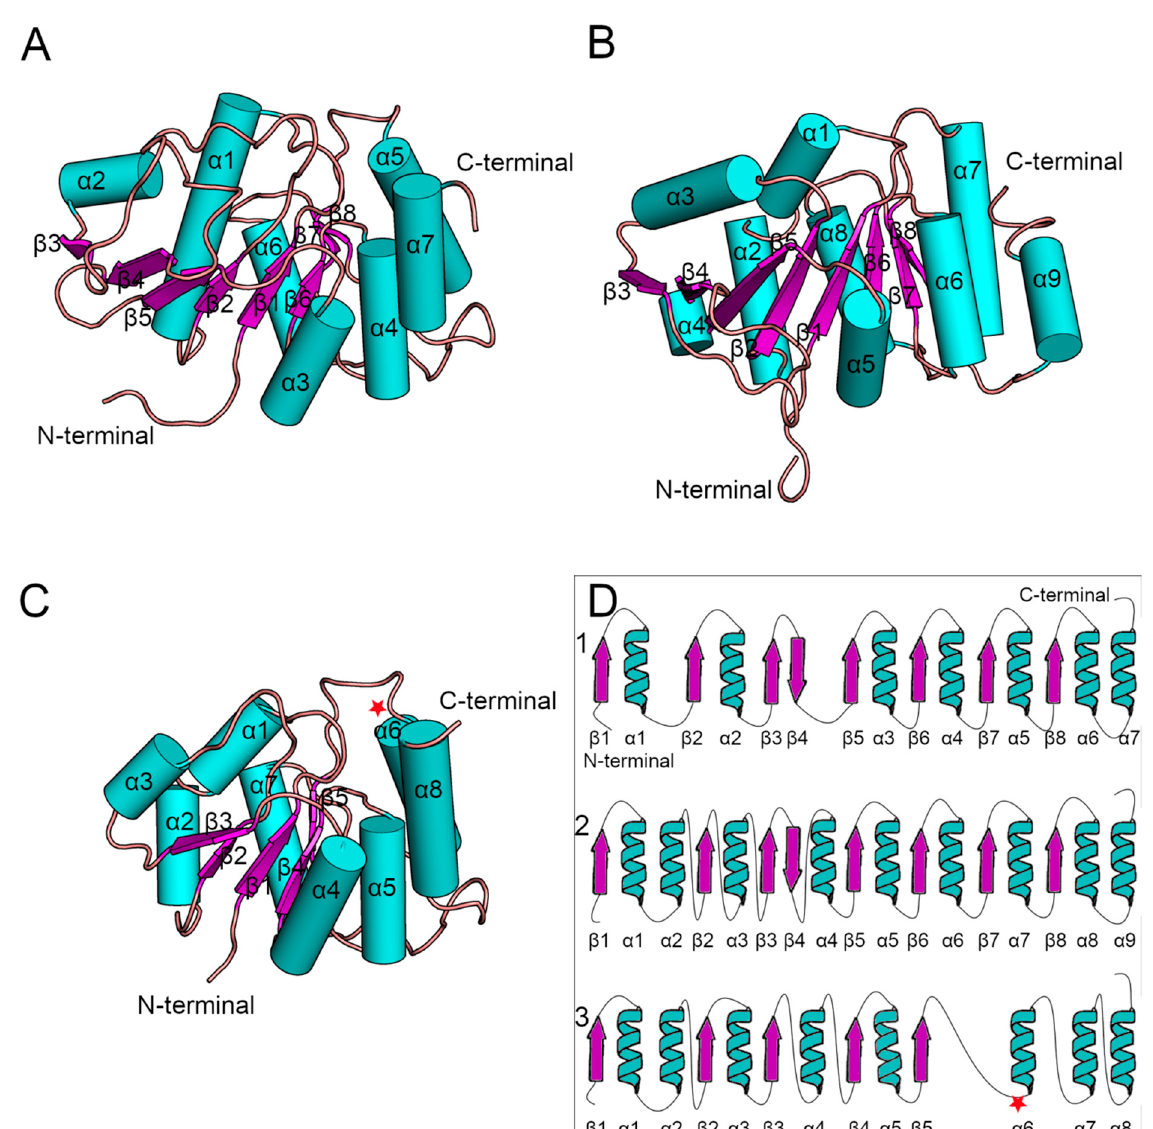
Figure 3. Comparison of known structures of the yeast ( Saccharomyces cerevisiae ) Alg13 structures with the homology model of human Alg13 (hAlg13_hm). ( A ) The yeast Alg13 structure solved by Wang et al. [14] (PDB ID: 2jzc), ( B ) the yeast Alg13 structure solved by Raman et al. [43] (PDB ID: 2ks6), ( C ) the homology model of the human Alg13 structure, ( D ) schematic representation of the Alg13 structures with corresponding secondary structures positioned in the same column: (1) Wang’s model, (2) Raman’s model and (3) hAlg13_hm homology model. The residue on the 107 position of the hAlg13_hm is marked by a red star.